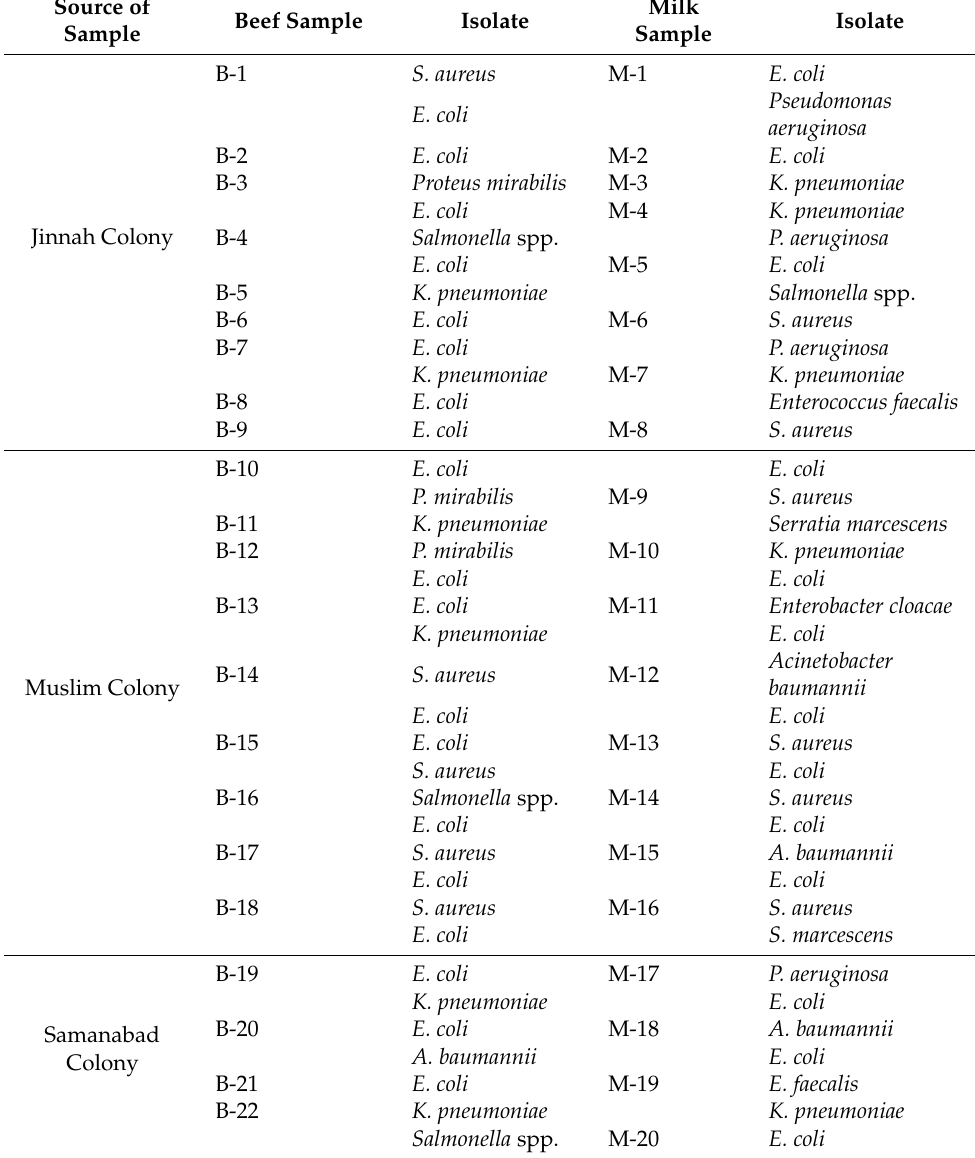
Town Colony ( n = 8); Samanabad Colony ( n = 8); People’s Colony ( n = 8); and Shadab Colony ( n = 8) (Figure 1). Of the 64 bacterial isolates from the 40 beef samples, 15 (23.4%) were present as polymicrobial populations and 35 (54.6%) as monomicrobial populations. Six (9.37%) of the isolates were gram-positive cocci, with S. aureus predominating, while 58 (90.6%) were gram-negative bacteria, of which 29 (50%) were E. coli , 11 (18.9%) were Klebsiella pneumoniae , and 7 (12%) were Salmonella spp. Of the 73 bacterial isolates from the 40 milk samples, 66 (90.4%) were polymicrobial and 7 (9.6%) were monomicrobial populations. gram-positive cocci made up thirteen of the seventy-three (17.8%) isolates, of which ten (76.9%) were S. aureus and three (23.1%) were Enterobacter cloacae . gram-negative bacteria accounted for sixty (82.1%) isolates, of which twenty-two (36.6%) were E. coli , twelve (20%) were K. pneumoniae, and six (8.2%) were Serratia marcescens (Table 2). Table 2. Bacteria detected in beef and bovine milk samples collected from different locations in the Faisalabad metropolitan area,